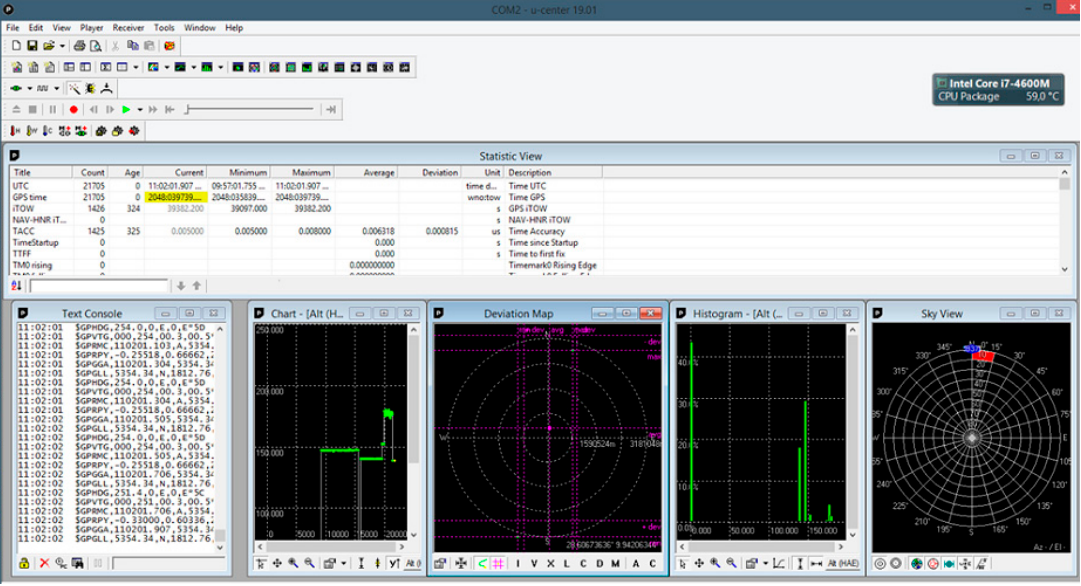
Figure 8. The window of the u-center software used to save messages recorded by the navigation multi-GNSS receiver in the National Marine Electronics Association (NMEA) standard.